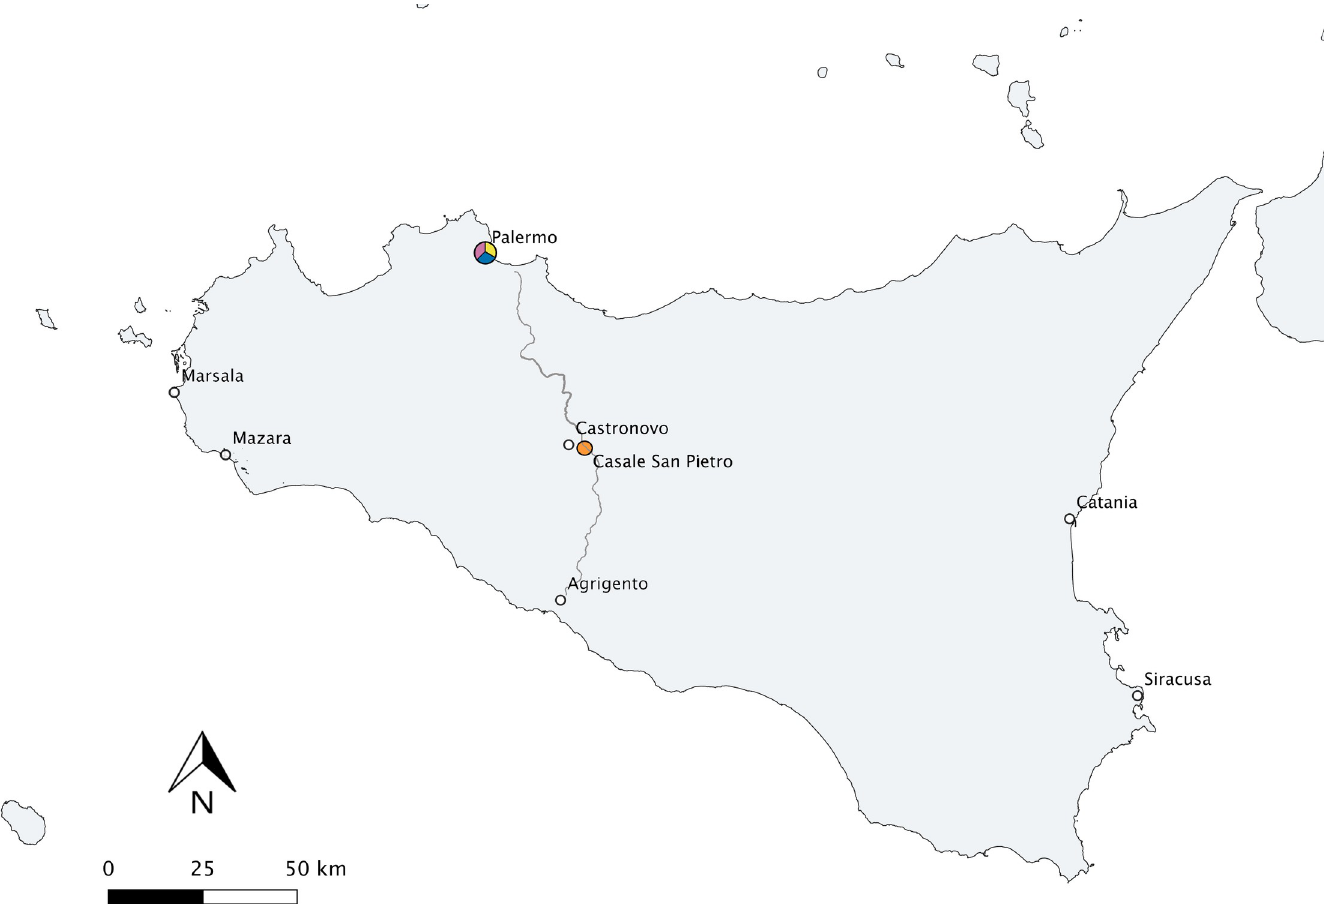
Fig 1. Map of Sicily showing the location of Palermo and Casale San Pietro. Colours represent the sites with ceramics used in this study where pink = CSP, yellow = GA, blue = PB and orange = CLESP. The main road between Palermo and Agrigento from North to South is marked on the